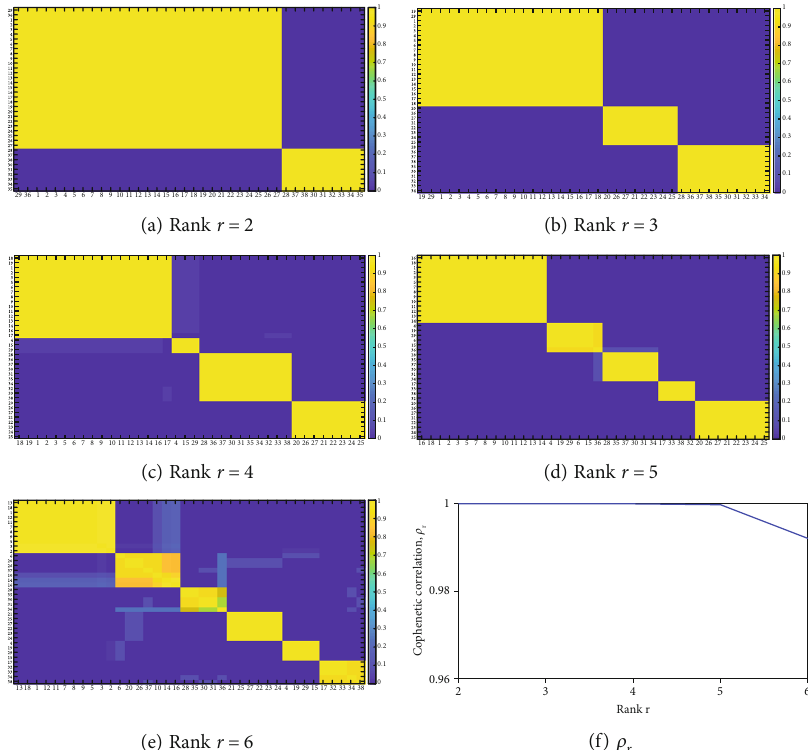
r = 2 ‐ 6 using r for